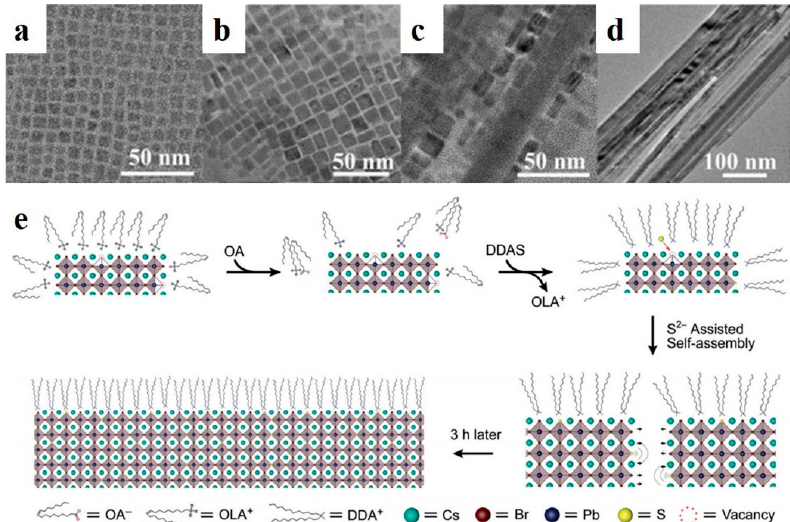
Figure 5. TEM images of samples obtained with different reaction times: ( a ) pristine HVPQDs, ( b ) 5 min, ( c ) 60 min, and ( d ) 180 min. ( e ) QD selfassembly mechanism. Reproduced with permission from reference [72]. Copyright 2019, John Wiley and Sons.